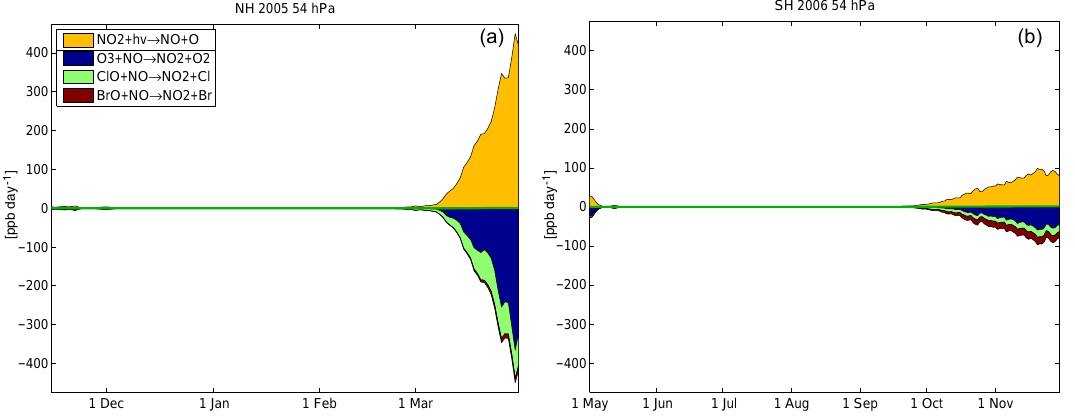
Figure 6. Vortex-averaged chemical reaction rates of reactions changing NO for the Arctic winter 2004–2005 (a) and the Antarctic winter 2006 (b) at 54hPa to illustrate NO x partitioning. Production reactions are shown as positive and are separated by a line in the legend from the loss reactions, which are shown as negative. The net change of NO is shown as a green line.